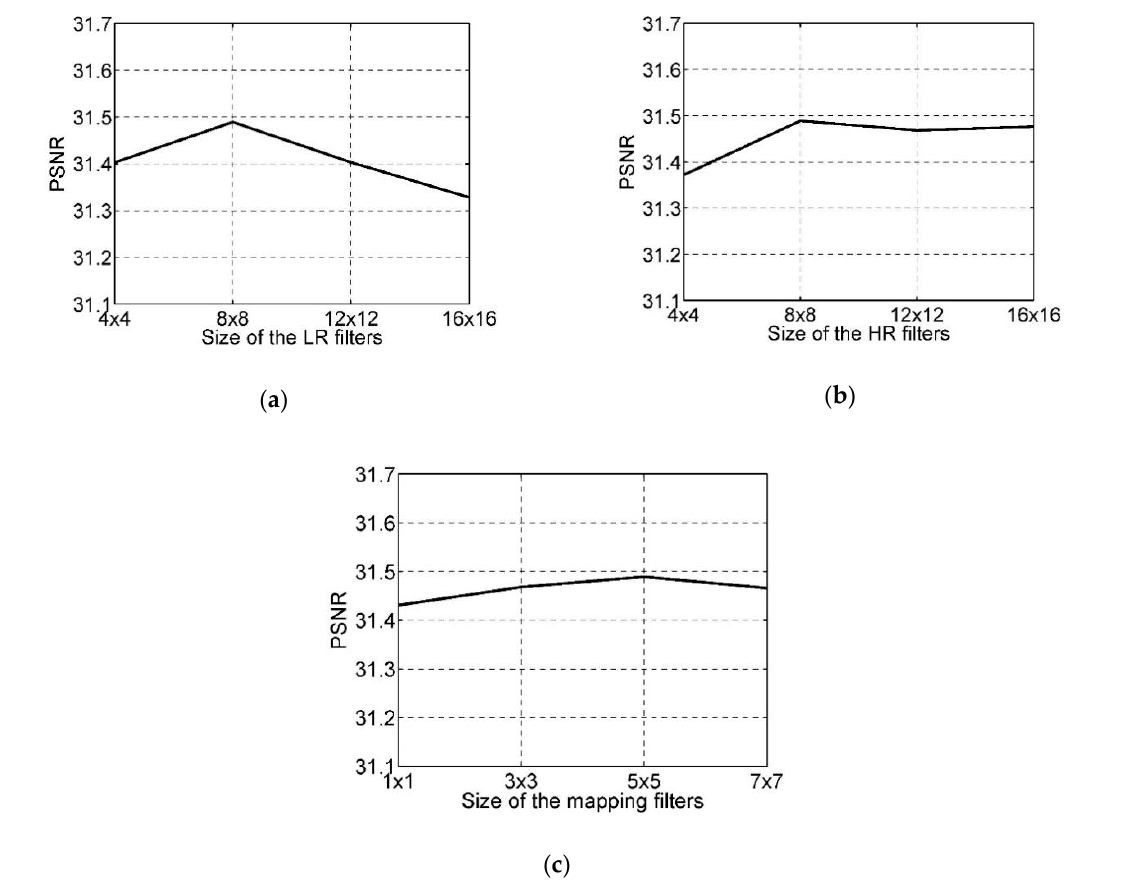
Figure 4. The impacts of the size of the filters. ( a ) 𝑠 (cid:3013) . ( b ) 𝑠 (cid:3009) . ( c ) 𝑠 (cid:3014) .